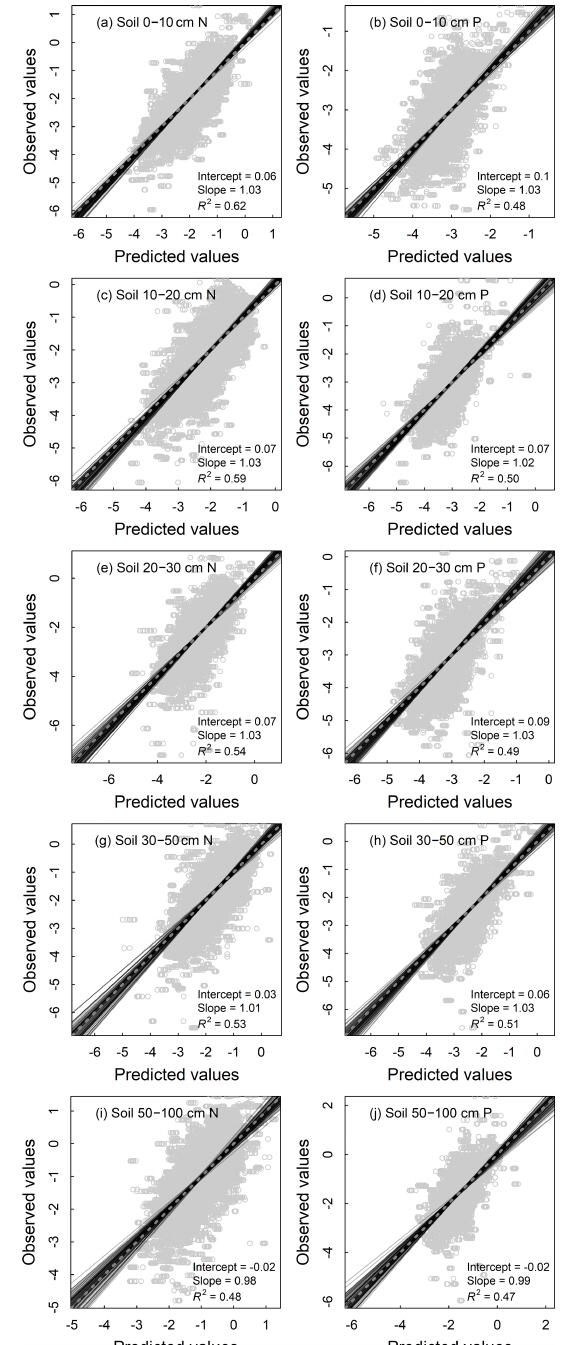
Figure 5. Fitting performance of random forest models for nutrient densities of 0–10cm (a, b) , 10–20cm (c, d) , 20–30cm (e, f) , 30– 50cm (g, h) , and 50–100cm (i, j) soil layers of terrestrial ecosys- tems in China based on 100 replications with the 10% validation data. Solid lines represent all the fitting lines, and the displayed pa- rameters stand for the average conditions. The dashed line denotes the 1 : 1